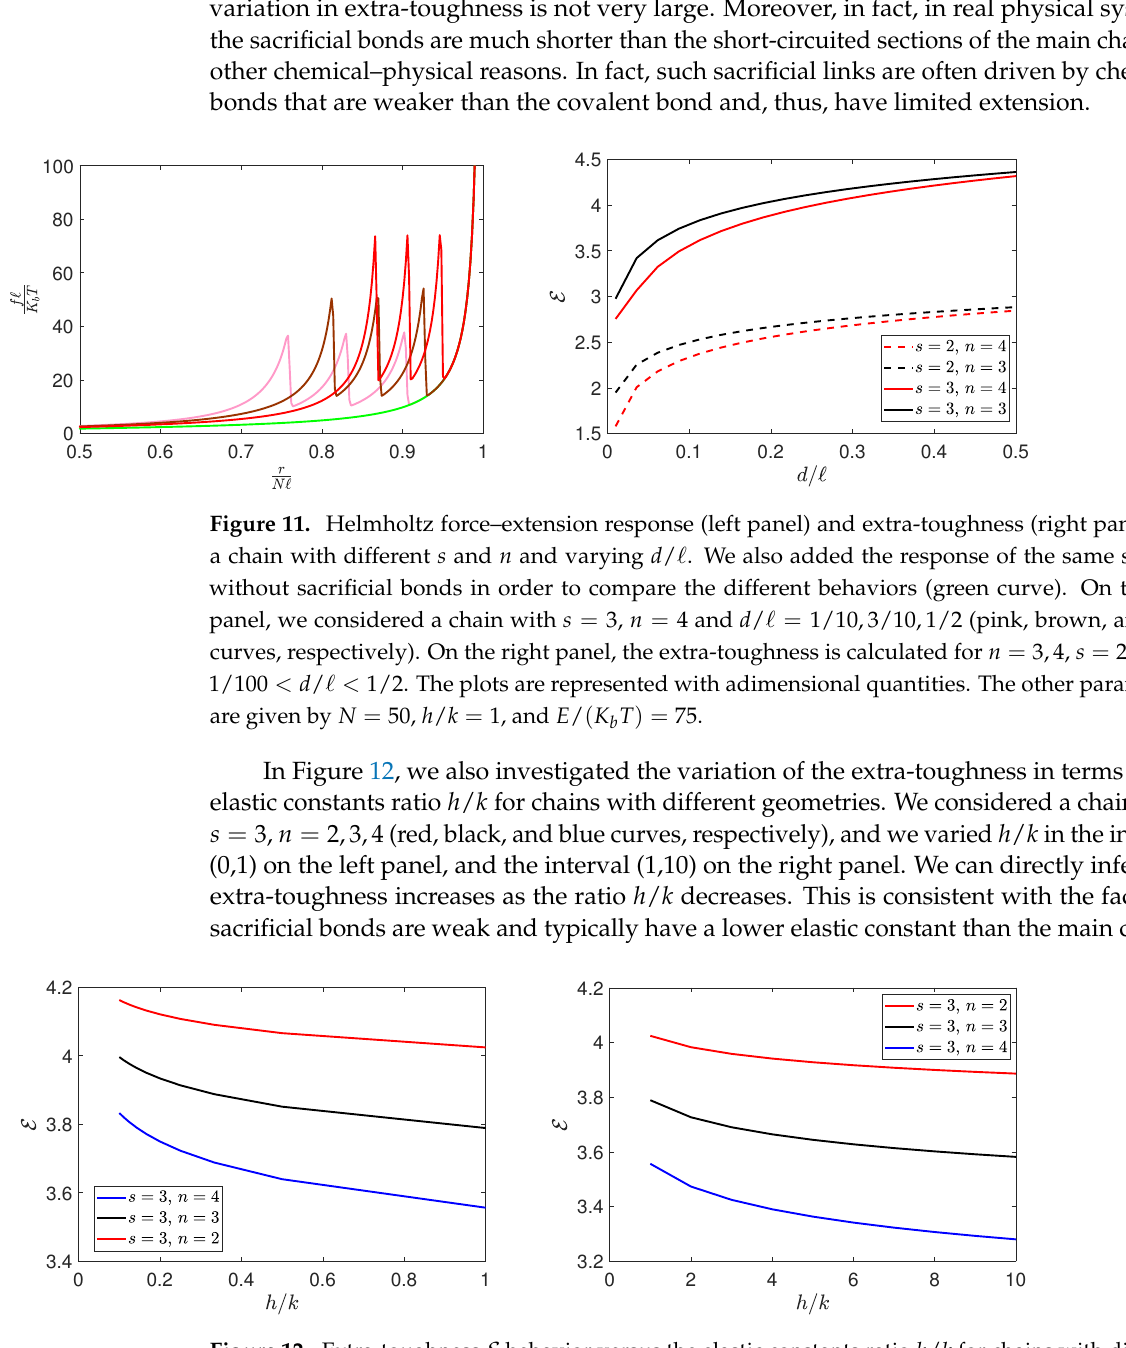
Figure 12. Extra-toughness E behavior versus the elastic constants ratio h / k for chains with different geometries. We considered a chain with s = 3, n = 2,3,4 (red, black, and blue curves, respectively) and we varied h / k in the interval (0,1) on the left panel, and in the interval (1,10) on the right panel. The plots are represented with adimensional quantities. The other parameters are given by N = 50, d / (cid:96) = 1/10, and E / ( K b T ) =